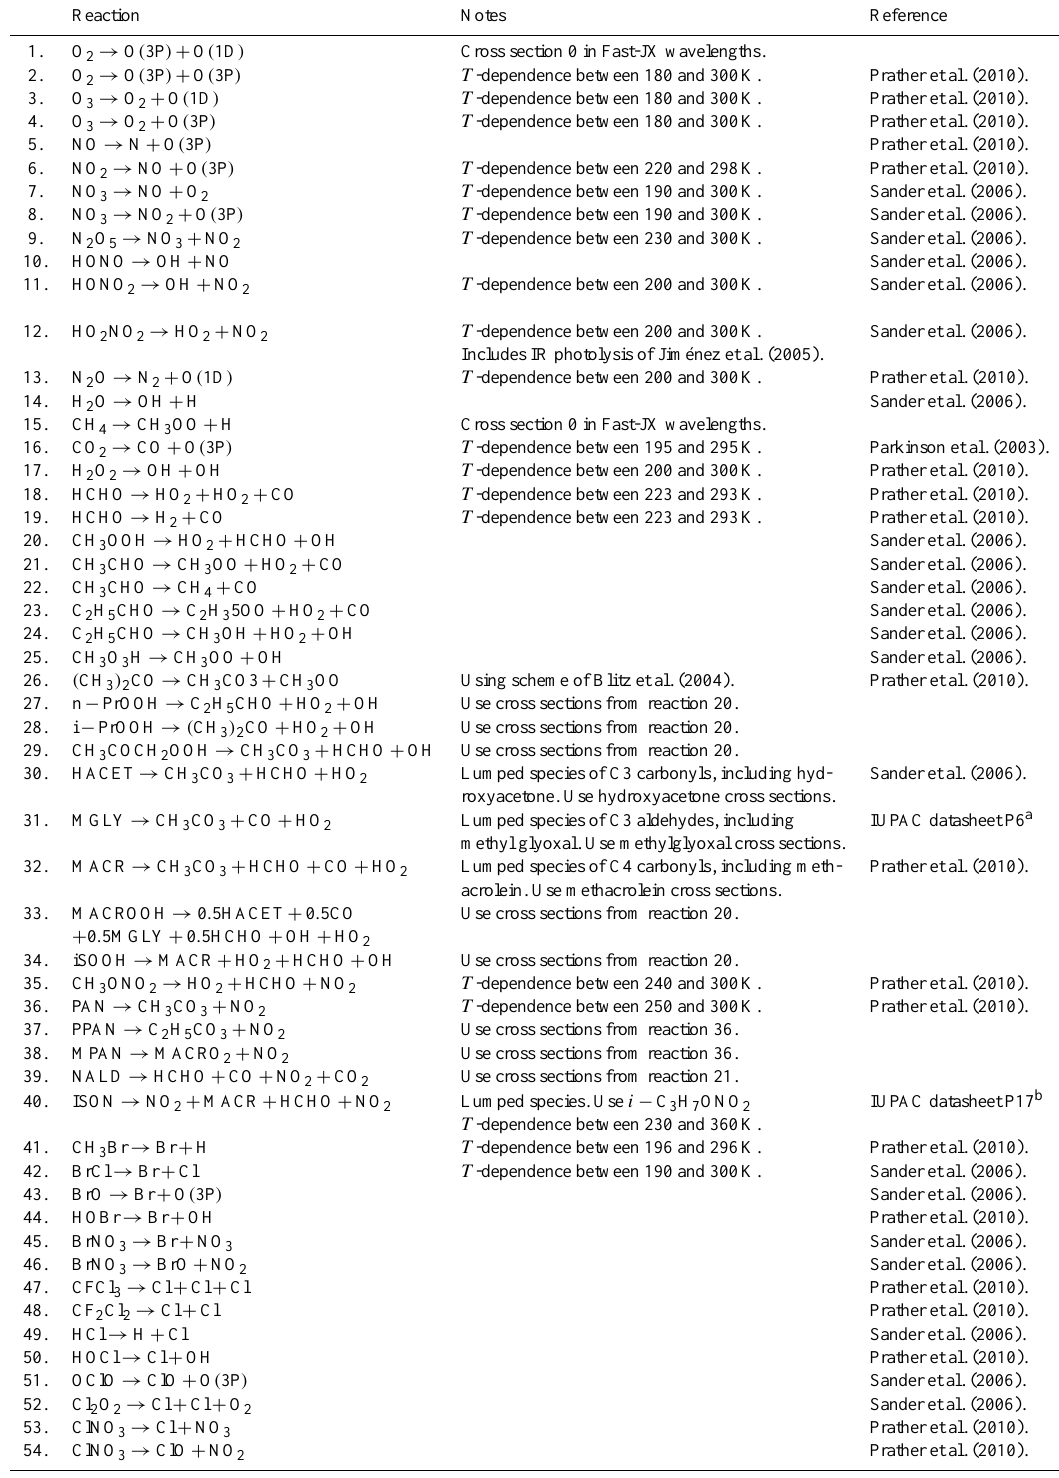
Table 4. Photolysis reactions employed in MetUM Fast-JX and the source of their corresponding absorption cross sections.